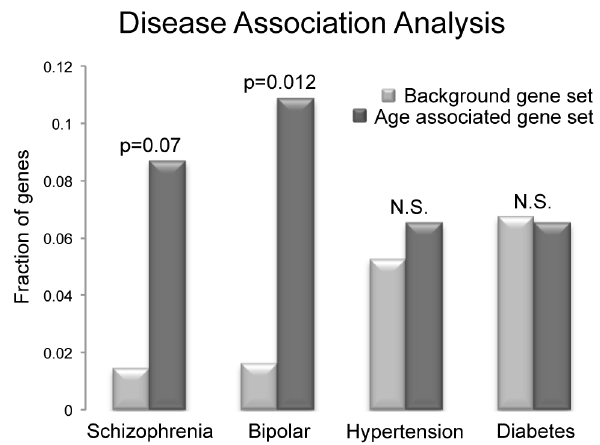
Figure 6. The frequency of disease associations within our gene set was analyzed and compared to the frequency of disease associations for all genes known to be associated with at least a single disease based on GAD annotation. Schizophre- nia, bipolar disorder, diabetes mellitus and hypertension were selected, as there were at least 3 genes in our small set of identified genes that are associated with these diseases. Only bipolar disorder was more frequently associated with our identified genes than the background set of genes, based on chi-squared analysis with multiple comparison correction (Bonferonni) of the 117 age associated genes analyzed (p=0.012), and schizophrenia also trended toward increased frequency (p=0.07). However, these are not considered significant enrichments if considering all genes in the genome (omitting the filter for a disease connection). The frequency of genes associated with hypertension and diabetes mellitus in the two groups was statistically similar.